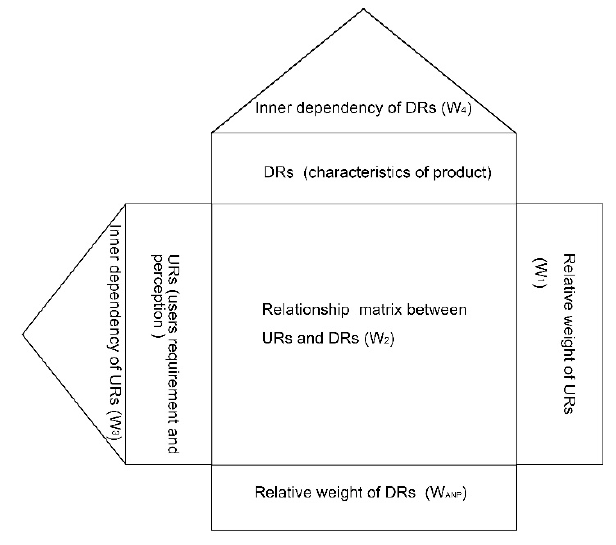
Figure 2. The integrated ANP-QFD method for product design (adapted from [41]).